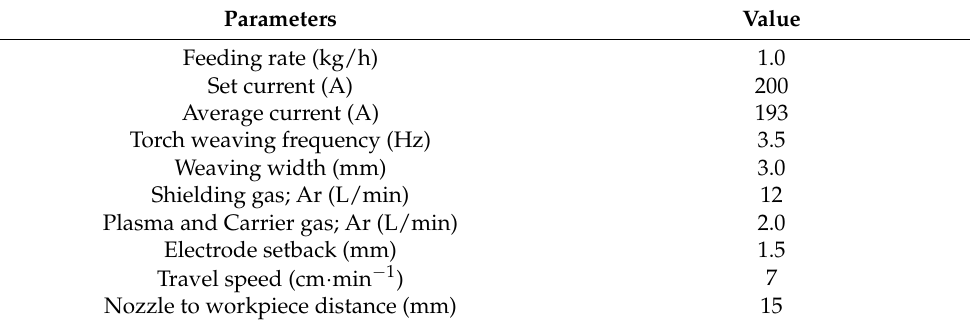
Table 2. Constant parameters of the PTA